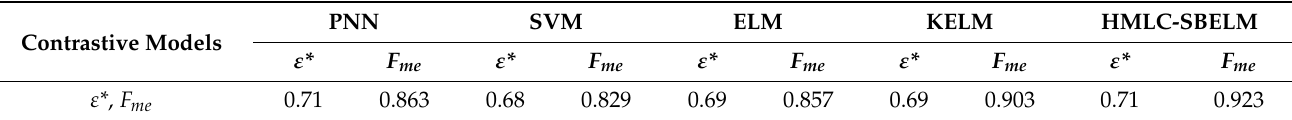
Table 4. The optimal decision threshold and F me .